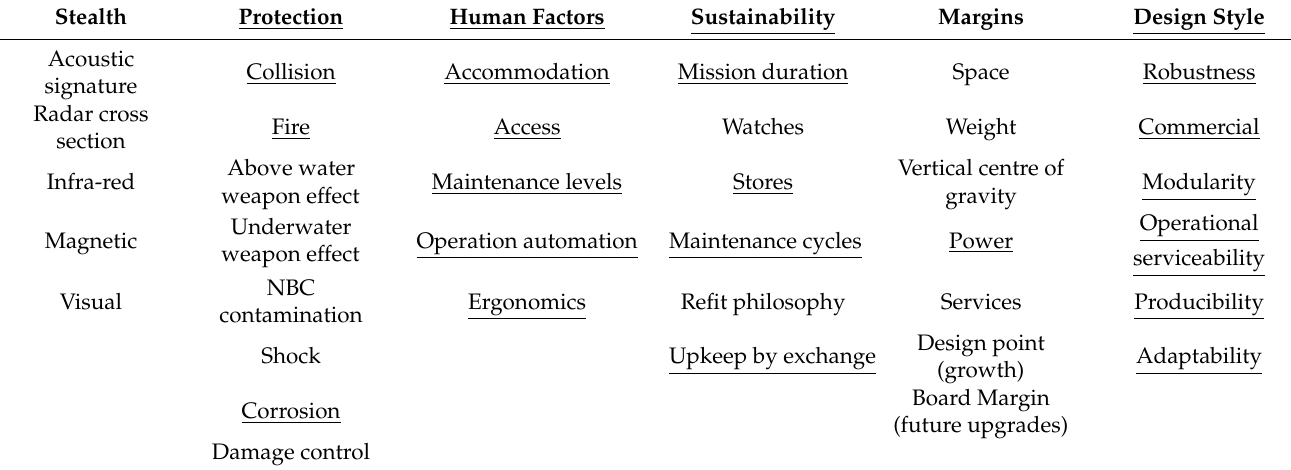
Table 1. Comparison of style topics relevant to a naval combatant (all) and a commercial service vessel (OPV) (underlined).